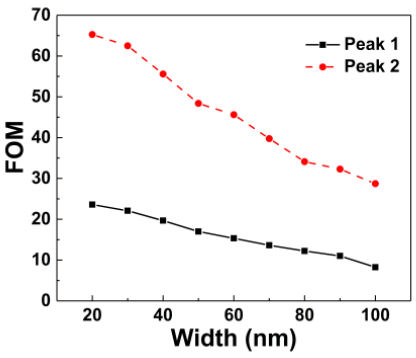
Figure 7. The relation between FOM and width of nanocavity.